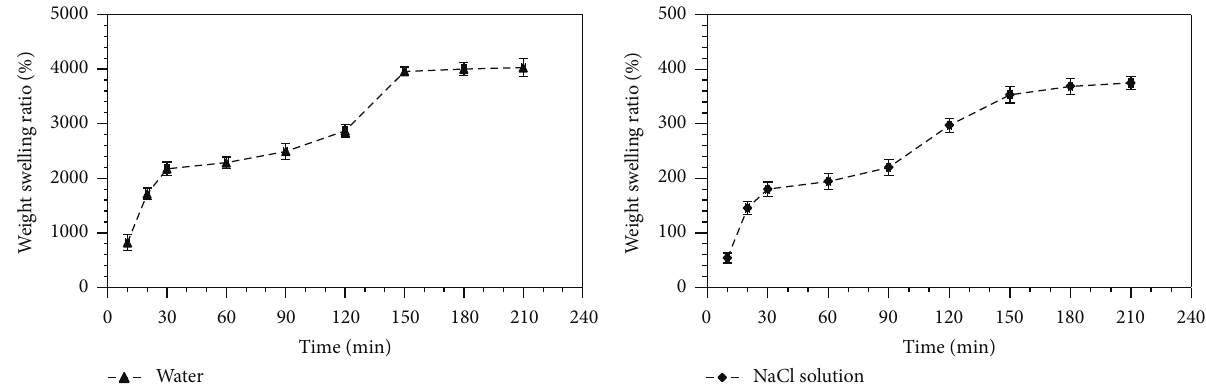
Figure 3: Weight swelling kinetics of F8 PAMPS polymers in water and salt solution at 25 ∘ C. F8 (shown in Table 1) is the PAMPS hydrogel synthesized by 35 g of AMPS (2-acrylamido-2-methylpropane sulfonic acid), 0.021 g of KPS (potassium persulfate), and 0.035 g of MBA (N, N 󸀠 -methylene-bis(acrylamide)). Error bars represent ± S.E. Table 3: Effects of different coating agents on tobacco pelleting seed germination under drought stress. Treatment